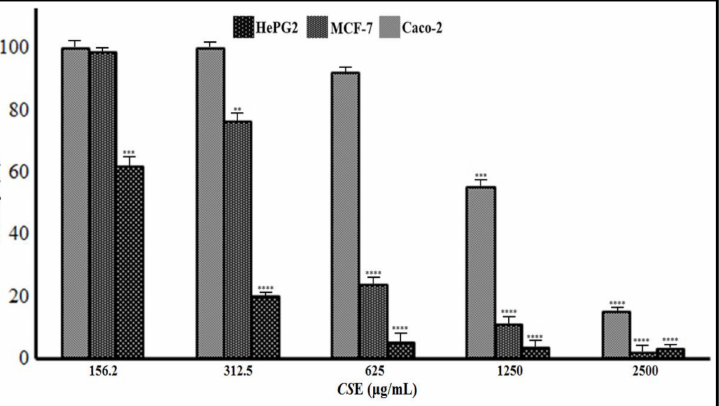
Figure 5. Effects of Cs E on HepG2, MCF-7, and Caco-2 cell viability after 48 h. Cells were incubated with the indicated concentration of Cs E while the percentage of cell viabilities were determined by MTT. Values used for plotting are means of triplicates, with each concentration tested in 7–8 wells. Statistical differences from control cultures are shown as bar graphs with error bars representing the means ± SD; ** p < 0.01, *** p < 0.001 and **** p <0.0001 vs. control (DMSO-treated)